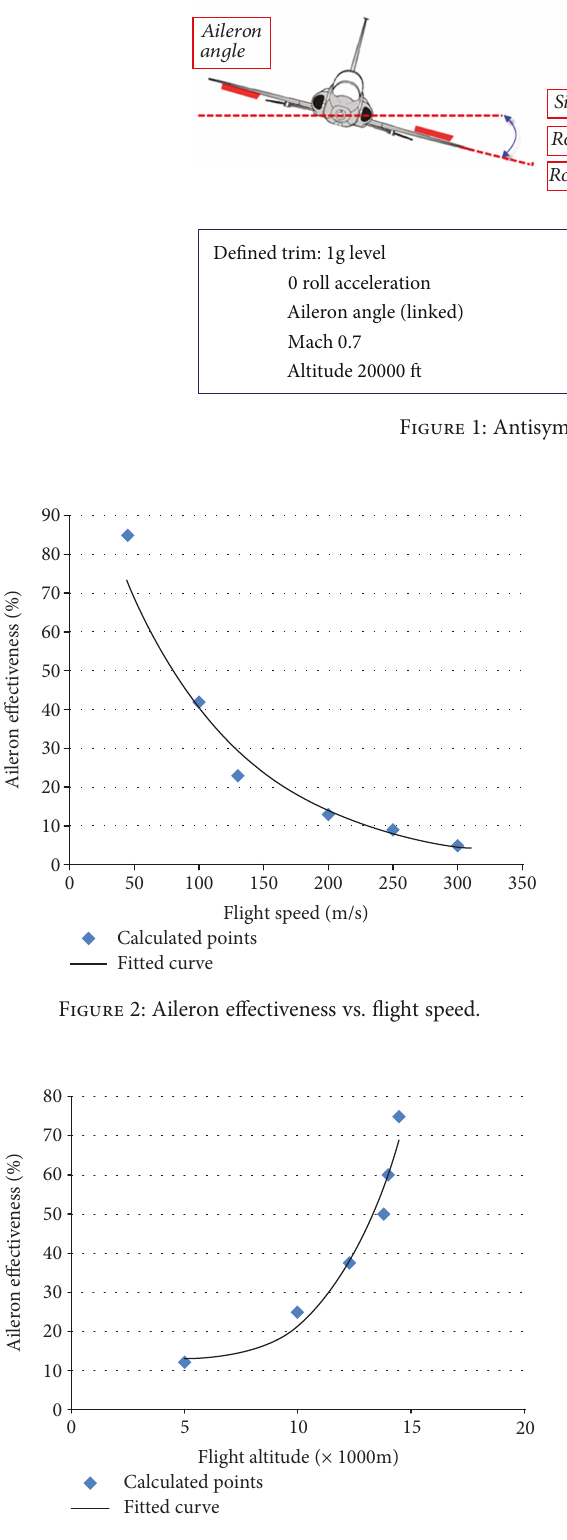
Figure 3: Aileron e ff ectiveness vs. fl ight